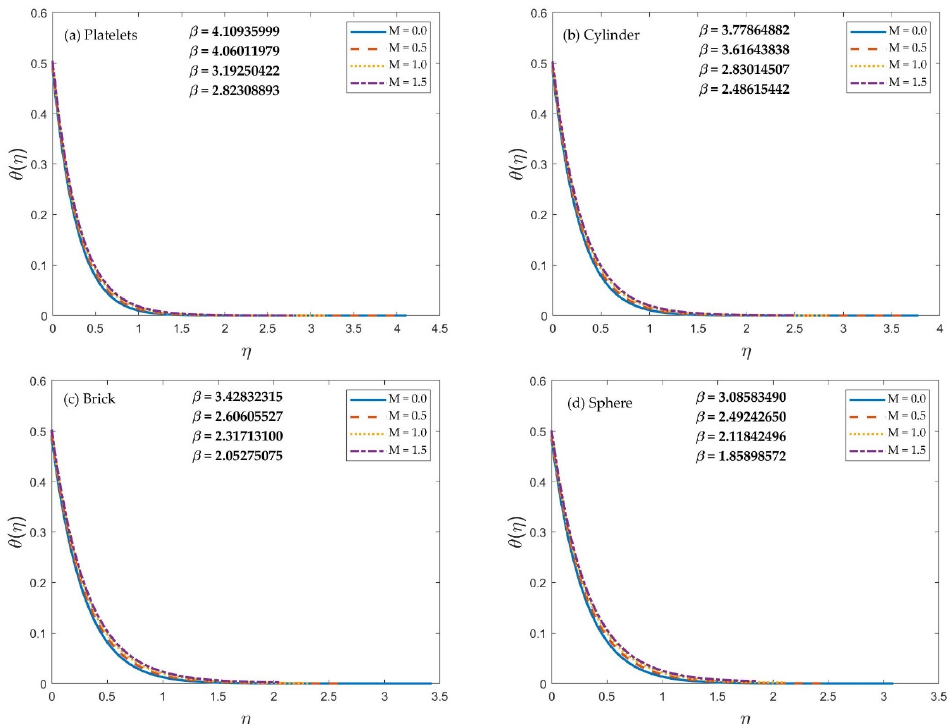
Figure 4. Impact of the magnetic parameter M on the temperature profile for S = 0.4, K = 0.5, ϕ = 0.02, Bi = 3.0, λ = − 2.0, α = π /4 and Pr = 8.0.